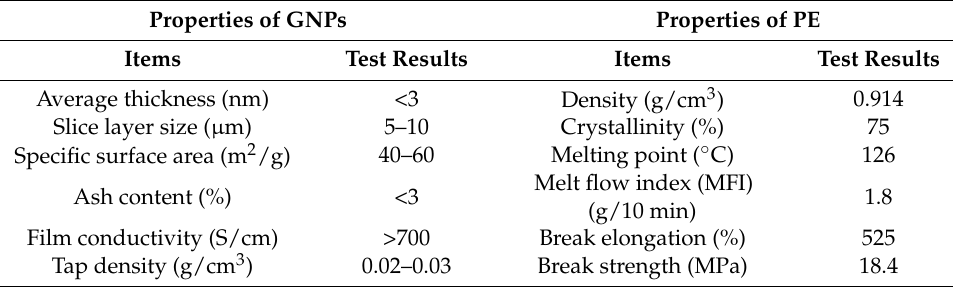
Table 2. The physical properties of